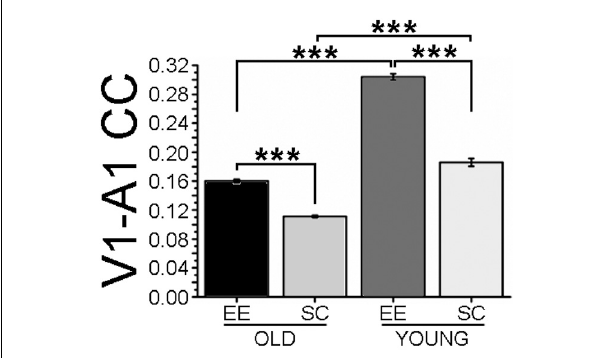
FIGURE 4 | Cross-correlation of LFPs recorded in visual and auditory cortices. The histogram shows cross-correlation (CC) between LFP electrical activity recorded in visual and auditory cortices. CC values for the EE-OLD, SC-OLD, EE-YOUNG and SC-YOUNG groups were compared with Two-Way ANOVA (rearing × age interaction, p < 0 . 001) followed by Holm-Sidak post-hoc test ( ∗∗∗ p < 0 . 001). In both old and young mice, EE induced an increase in CC compared to SC controls.